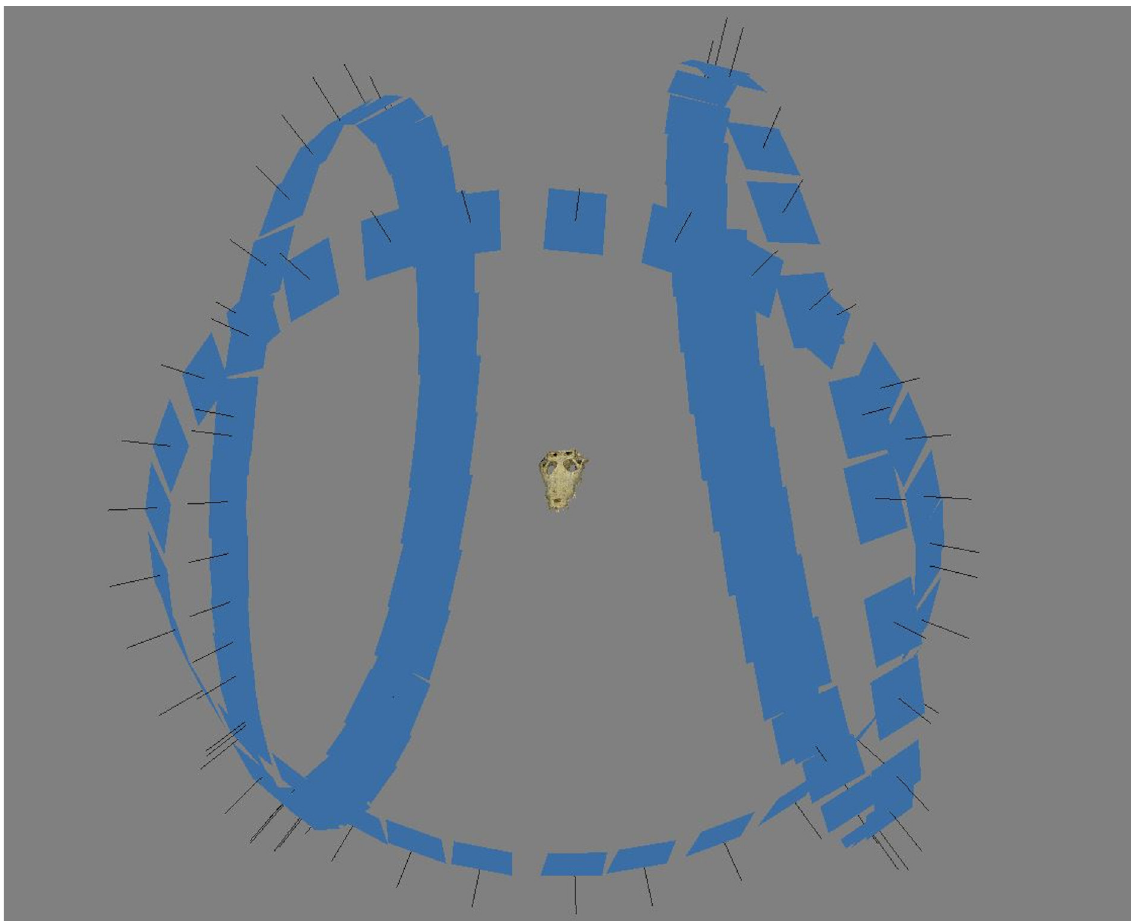
Fig. 3.3. Camera positions of three rotations. The top part of the crocodile skull was placed on a rotary table and turned on three different sides after a full turn. During the photoshoot the camera was kept at a fixed